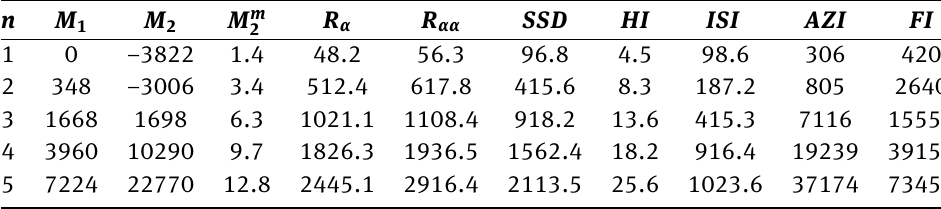
Table 4: Comparison of all indices for HDN 1( n ) .